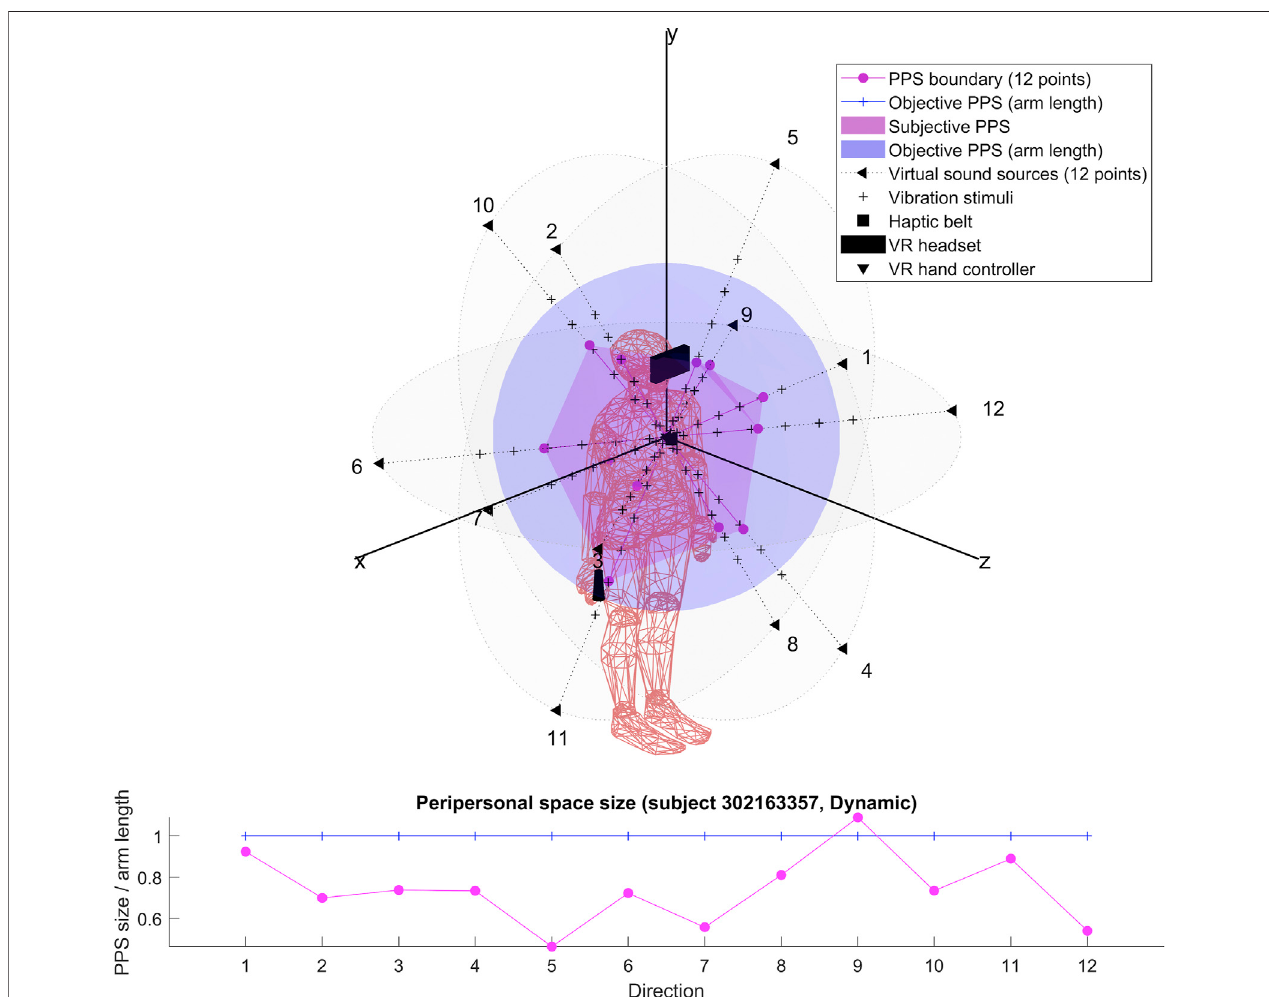
FIGURE 8 | PPS 3D representation for subject 302163357 dynamic